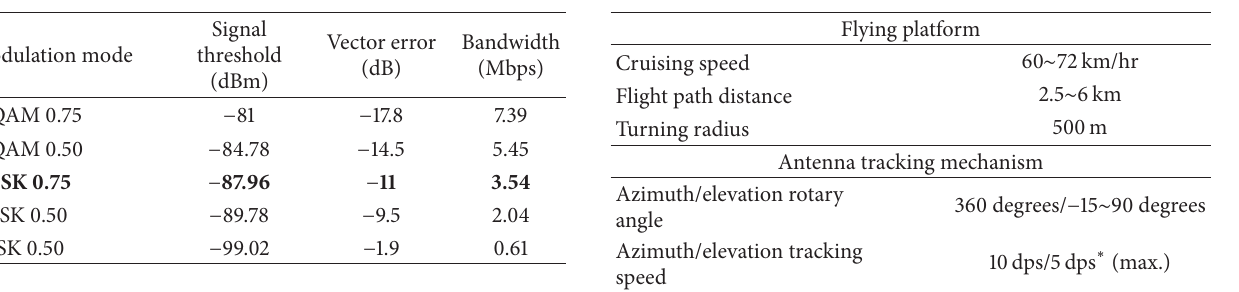
Table 4: Ground tracking mechanism specification and flying